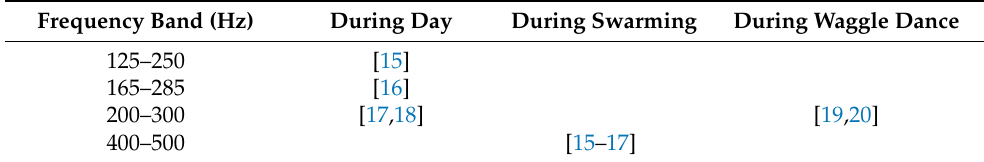
Table 1. Literature view on the frequency bands detected in a beehive. Frequency Band (Hz) During Day During Swarming During Waggle